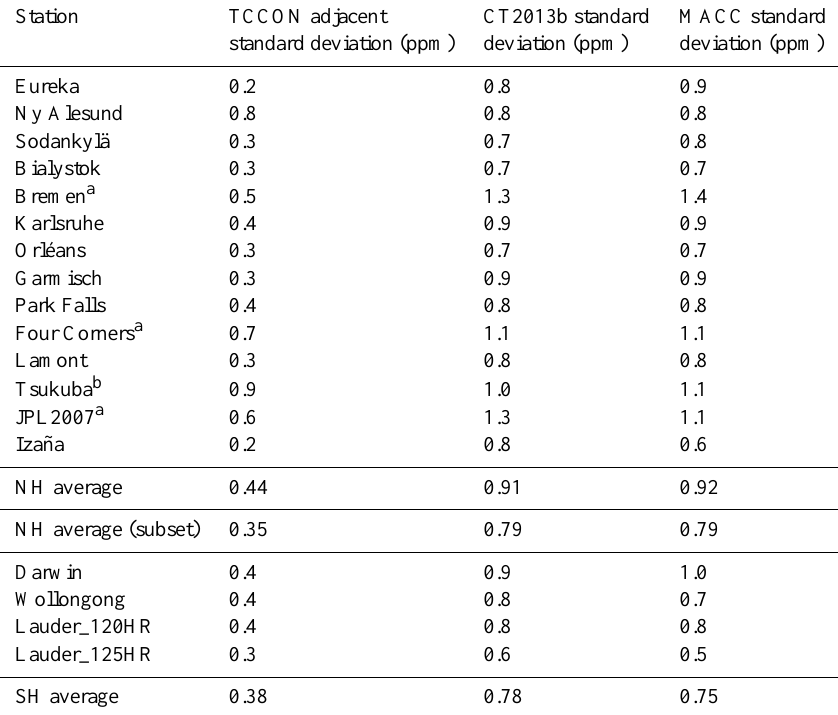
Table B1. We estimate the 90min average TCCON standard deviation error by calculating the standard deviation of adjacent time points and model standard deviation of CT2013b and MACC13.1 vs. TCCON by station. These values are used to estimate theoretical maximum correlations for seasonal cycle and diurnal correlations using Eq. (3). a denotes stations strongly influenced by local effects and b Tsukuba has higher TCCON error. These stations have been removed in the NH average (subset)